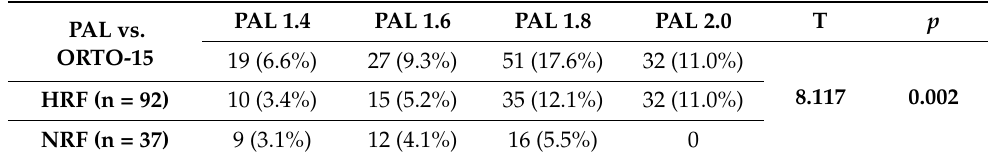
Table 4. Relationship between physical activity level and the group at increased risk for orthorexia (n = 129).